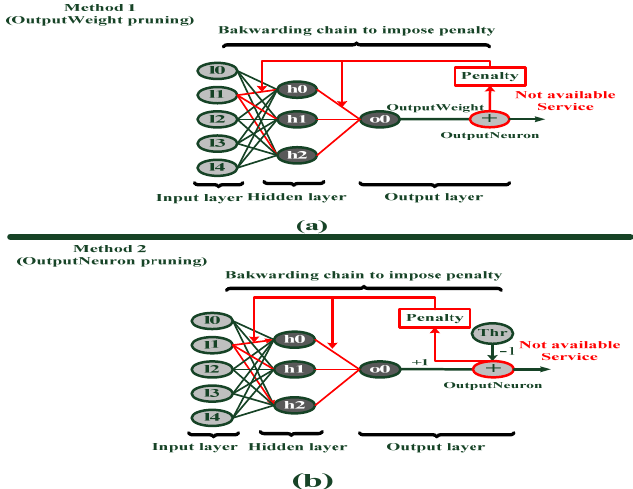
Figure 6. Backwarding chain to trust creation: ( a ) Imposing penalty to output and hidden layer’s weight and trust creation considering the method 1; ( b ) Imposing penalty to output and hidden layer’s weight and trust creation considering the method 2.